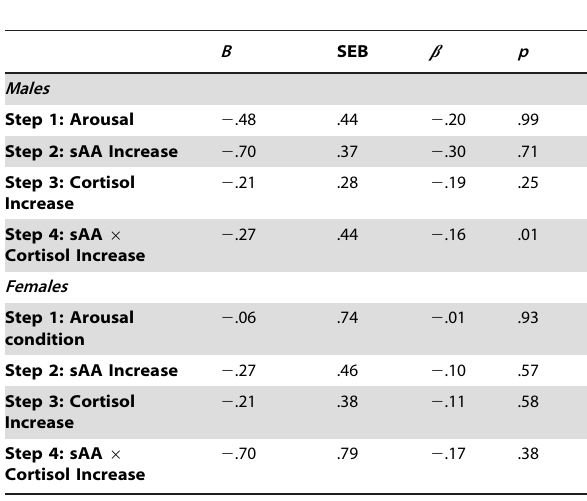
Table 6. Summary of Hierarchical Regression Models for Intrusions of Neutral